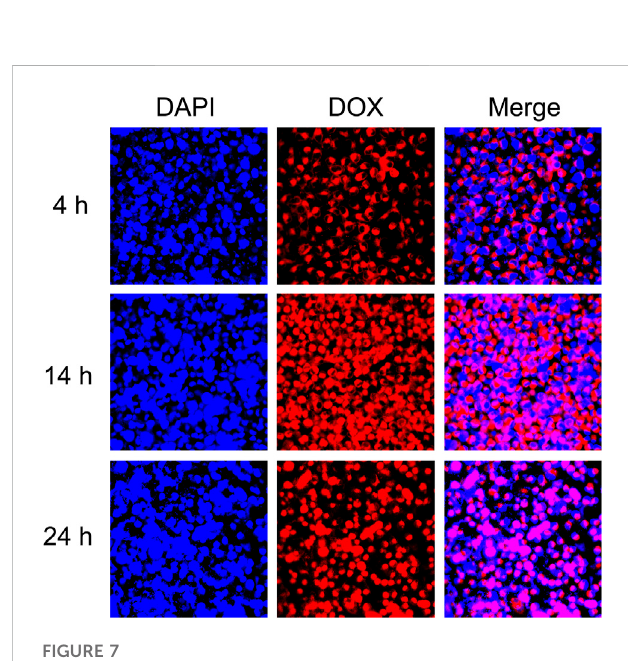
FIGURE 7 CLSM images of